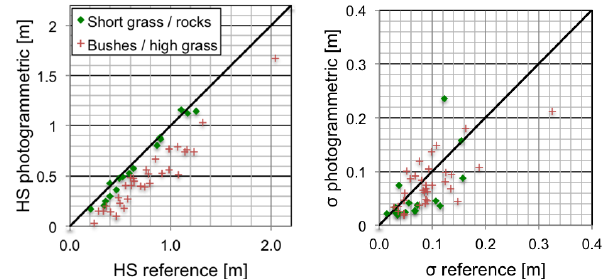
Figure 5. Statistical evaluation of the HS measurements (left panel) and the standard deviations σ of HS within a specific reference plot (right panel). The overall correlation coefficient R 2 for the HS val- ues is 0.84 ( R 2 = 0.98 for the class short grass/rocks and R 2 = 0.92 for the class bushes/high